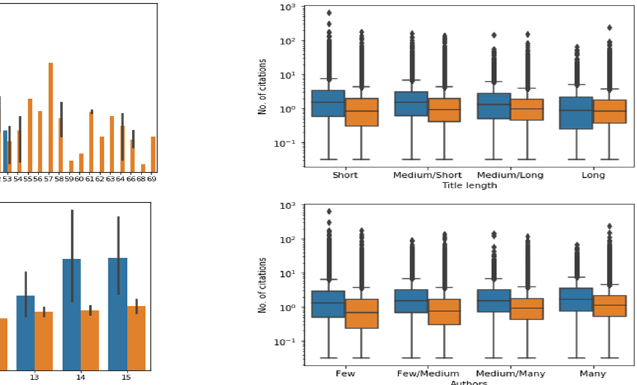
Figure 4. Above, left: Distribution of normalized citations by title length in reviews ( blue ) and original articles ( orange ); right: boxplot representing the normalized citation count by quartiles of title length in reviews or original articles. Below, left: Distribution of normalized citations by author count in reviews ( blue ) and original articles ( orange ); right: boxplot representing the normalized citation count by quartiles of number of authors in reviews or original articles.